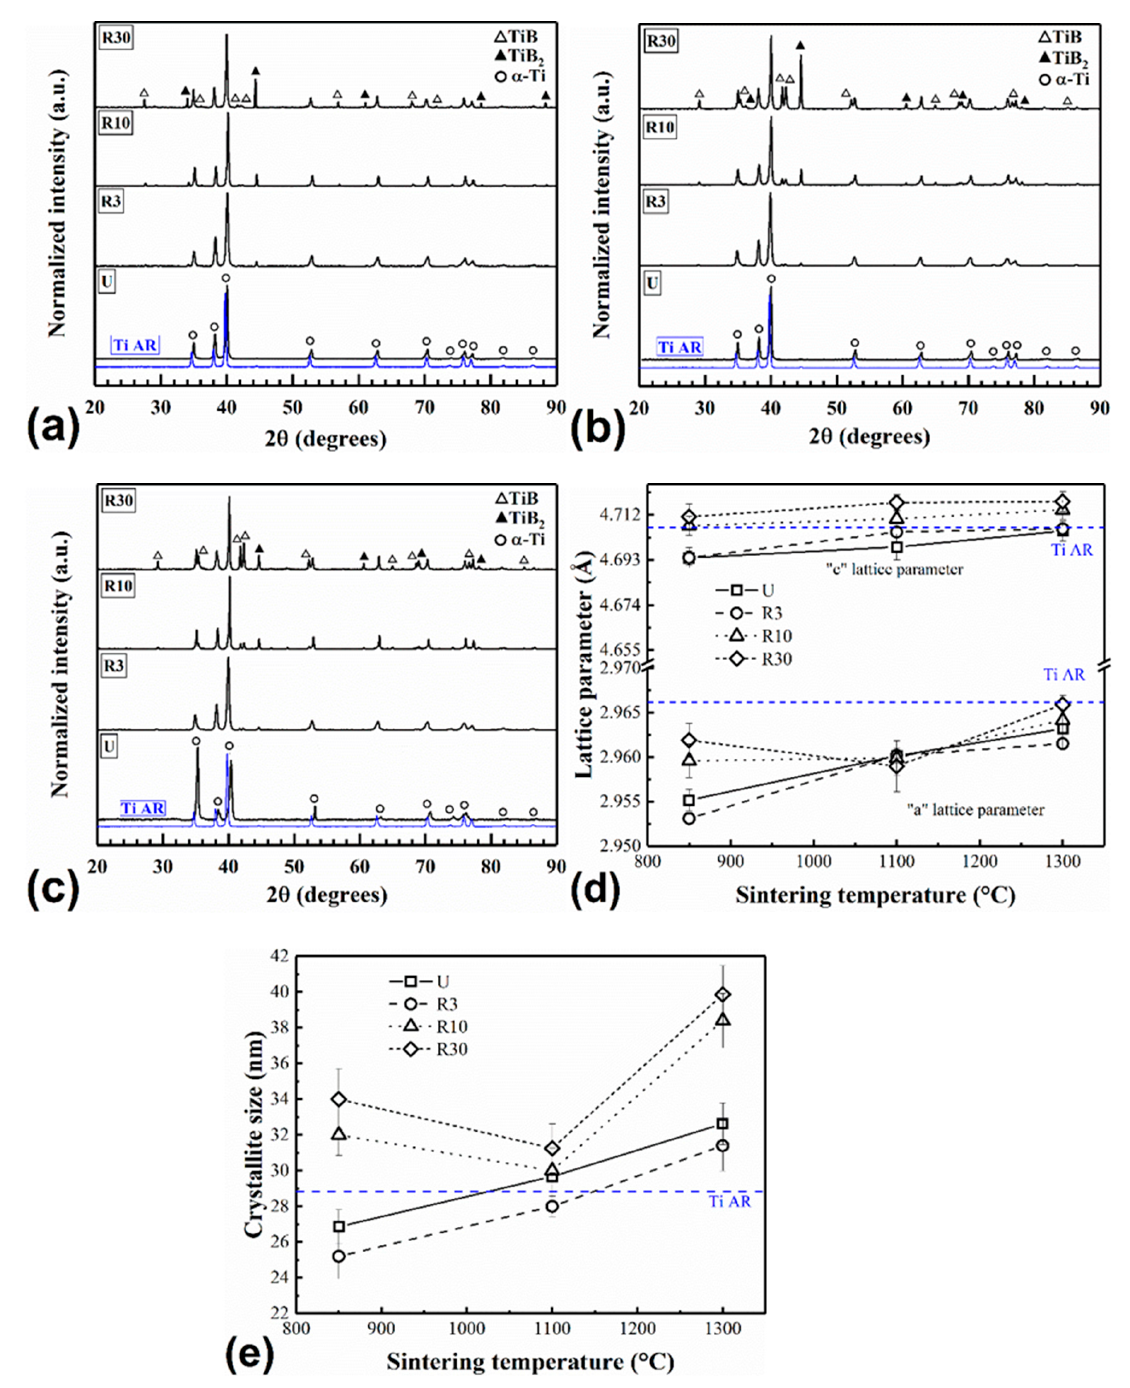
Figure 6. XRD patterns for the U and R samples after sintering at: ( a ) 850, ( b ) 1100 and, ( c ) 1300 °C; ( d ) lattice parameters, and ( e ) crystallite size of α -Ti for U and R samples as a function of the sintering temperature.